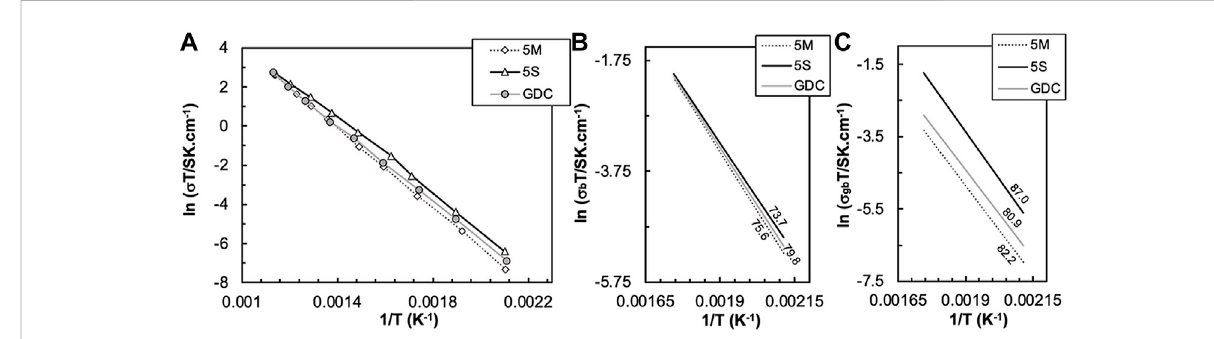
FIGURE 7 Arrhenius-typeplotsoftotal (A) ,bulk (B) andgrainboundaryconductivity (C) ofGDC-basedmaterialssinteredwithoutandwithNLC(Griloetal., 2020). In (B , C) , lines correspond to data linear trends used to estimate E a (kJ.mol − 1